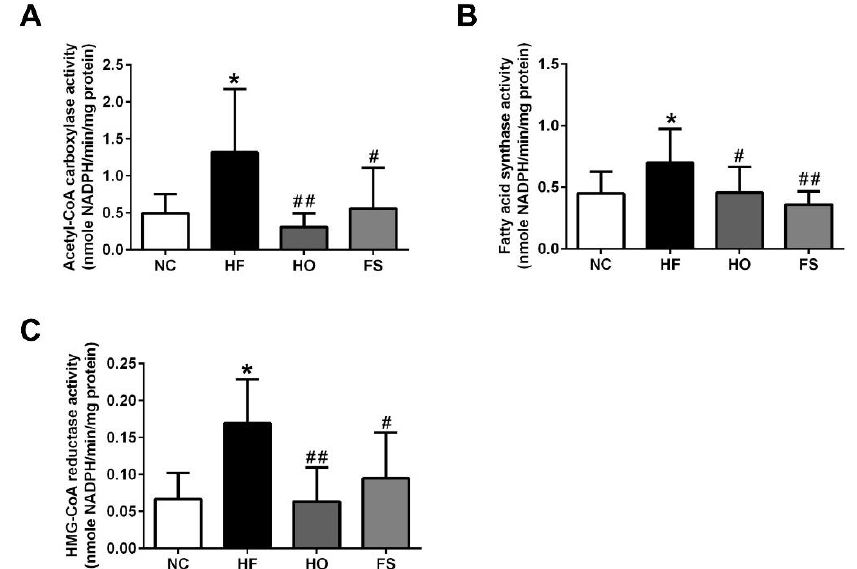
Figure 2. Effects of RMD and orlistat on the activities of acetyl-CoA carboxylase (ACC), fatty acid synthase (FAS), and HMG-CoA reductase (HMGCR) in the livers of HF-diet-fed rats. Enzymatic activities for ACC ( A ), FAS ( B ), and HMGCR ( C ) in the livers of HF-diet-fed rats treated with or without RMD and orlistat for 8 weeks are shown. Results are expressed as mean ± S.D. for each group ( n = 8). * present p < 0.05, ** present p < 0.01 as compared with NC group; # present p < 0.05, ## present p < 0.01 as compared with HF group. NC: normal control diet; HF: high-fat diet; HO: high-fat diet containing 0.2% orlistat; FS: high-fat diet containing 5% Fibersol-2.